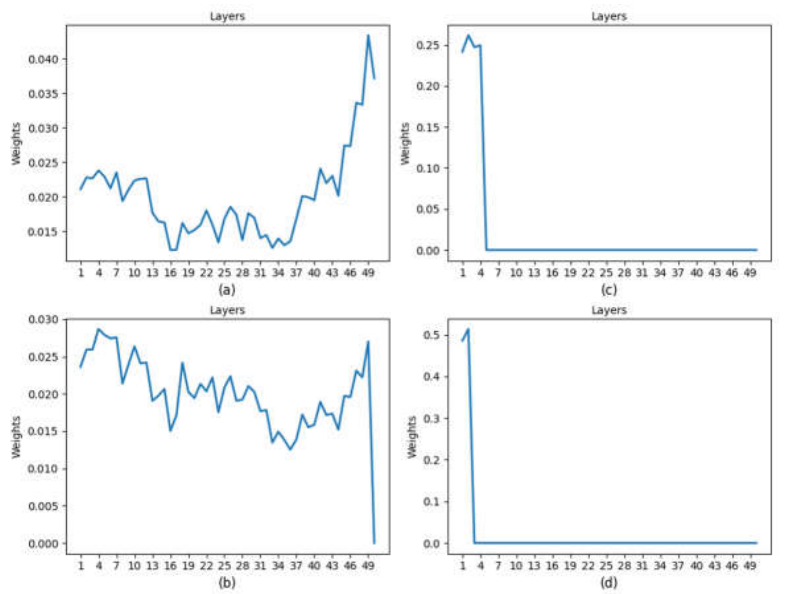
Figure 12. Layers’ relevance weights learned by the proposed class-dependent ANNA on CIFAR-10 dataset after training the model using: ( a ) 1 batch; ( b ) 5 batches; ( c ) 6 batches; ( d ) 7 batches.